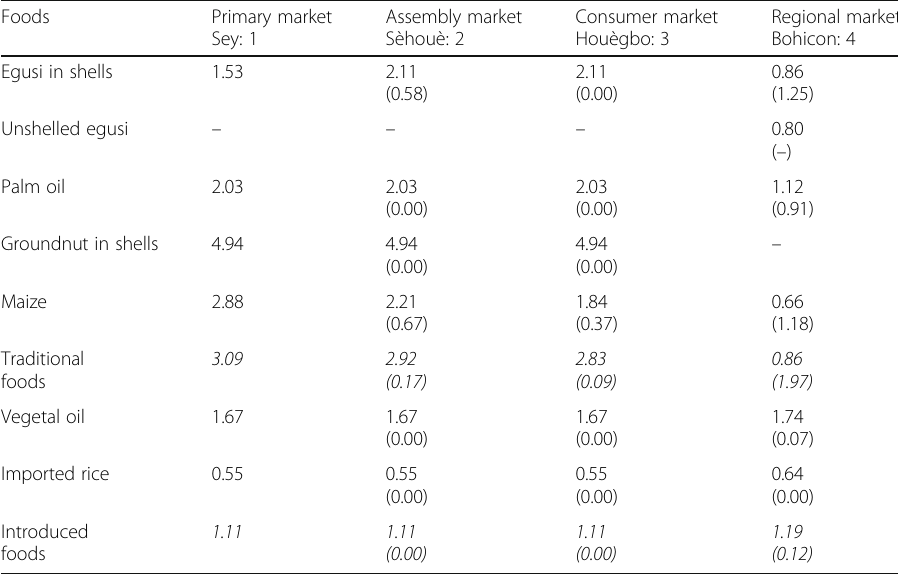
Table 4 Price instability coefficients and gaps between successive market pairs in the Toffo- Bohicon market